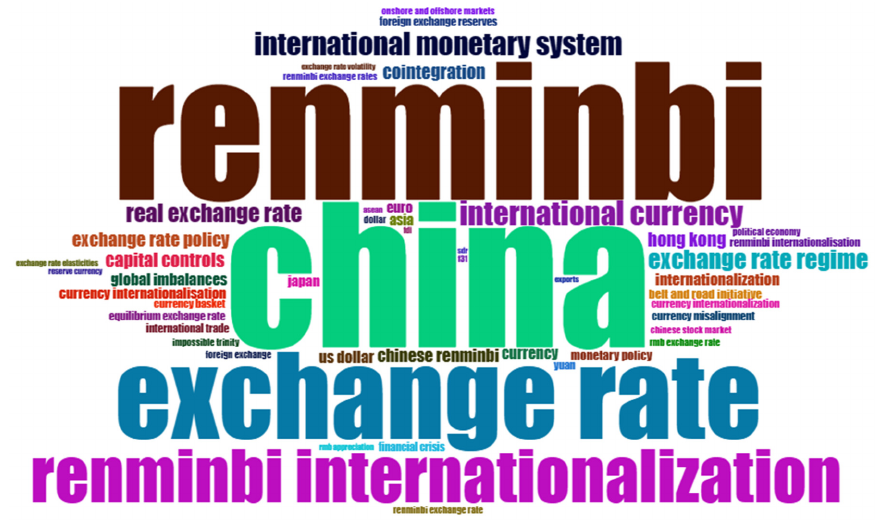
Figure 4. Top authors’ keywords as a Word Cloud. Source: Authors’ elaboration using Biblioshiny. Top authors’ keywords (30 with 7 minimum occurrences) are represented by a Tree Map in Figure 5. China is the most common keyword with 120 occurrences (19%) followed